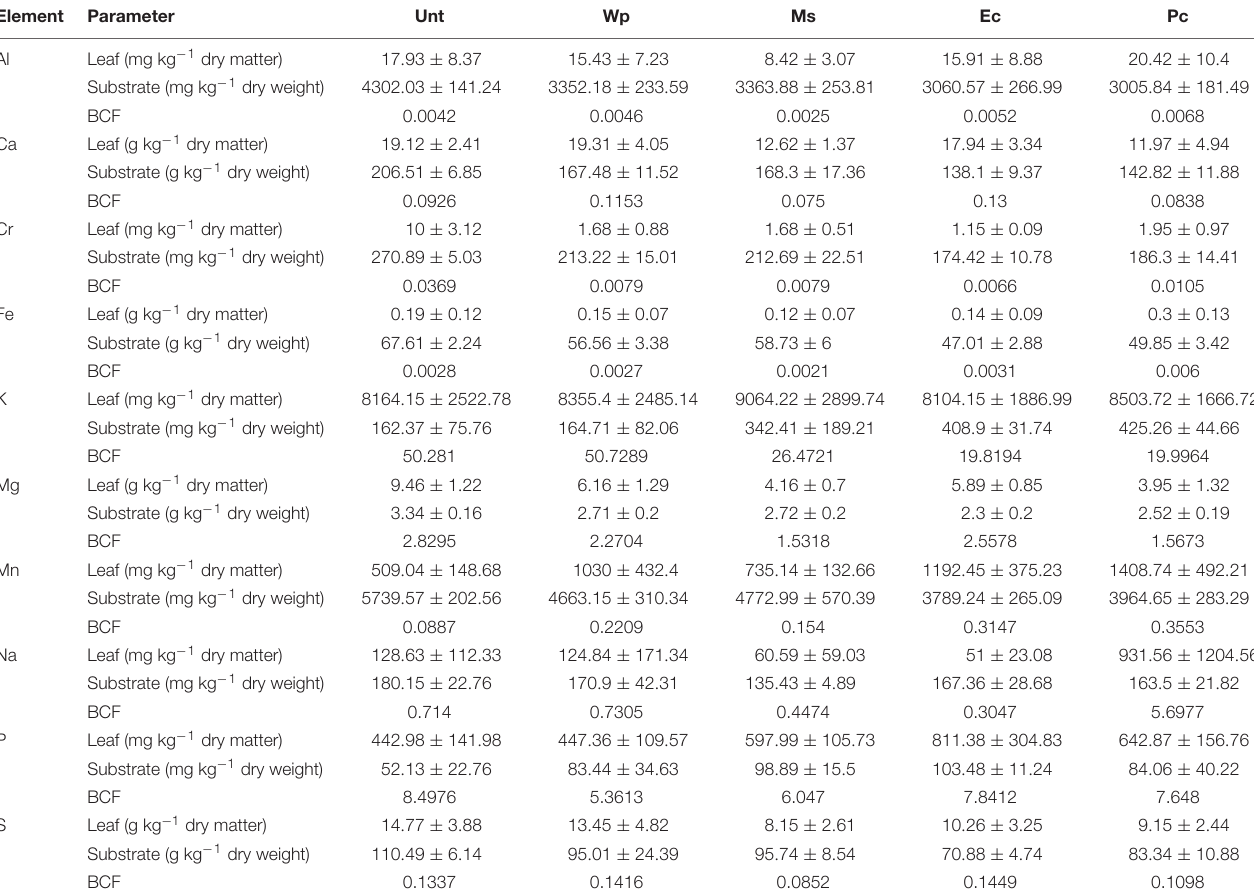
TABLE 1 | Concentrations of elements in the RRG substrates and in leaves of birch seedlings under the five RRG treatments after a 3-month growth period. Element Parameter Unt Wp Ms